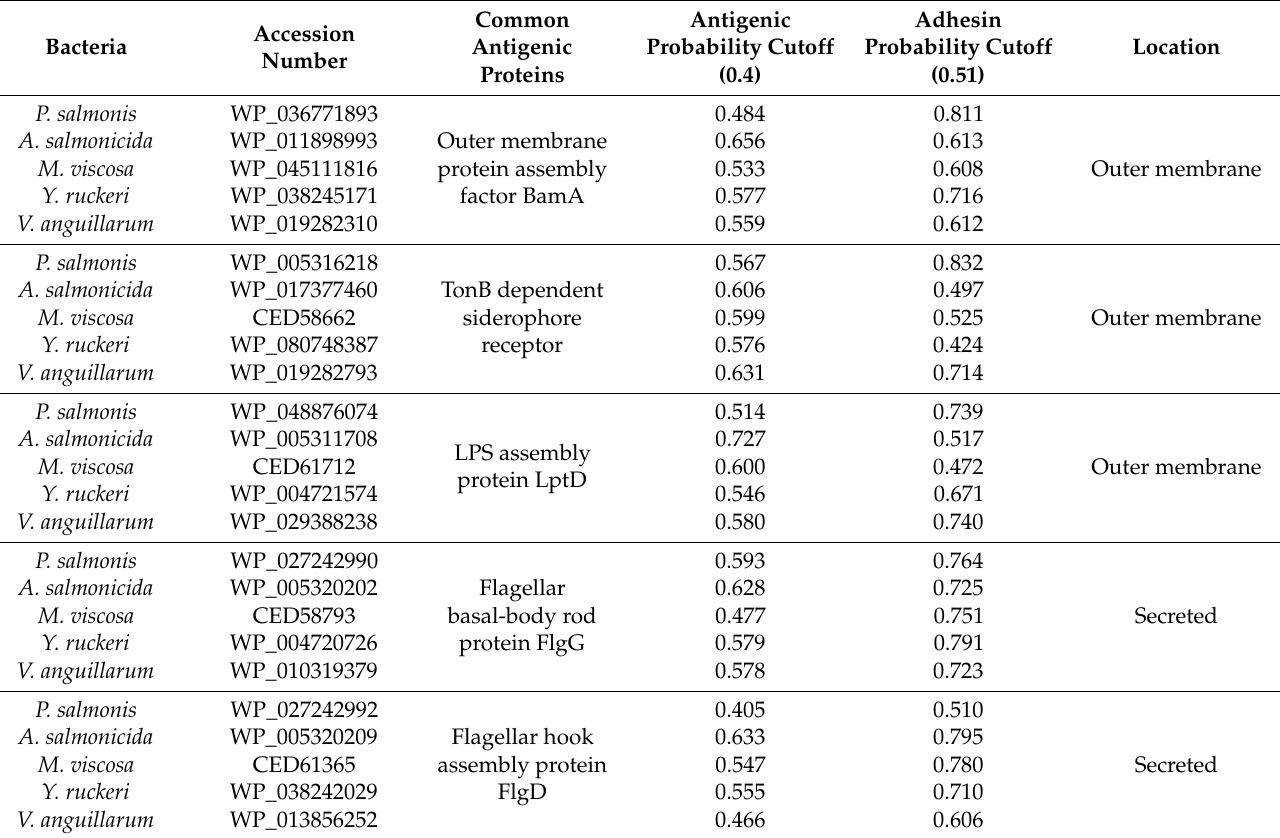
Figure 3. Immunogenic proteins identified across all bacterial proteomes from marine pathogens of fish used in this study. ( A ) Outer membrane proteins; ( B ) Secreted proteins. Table 2. Common potential vaccine candidates identified across all bacteria